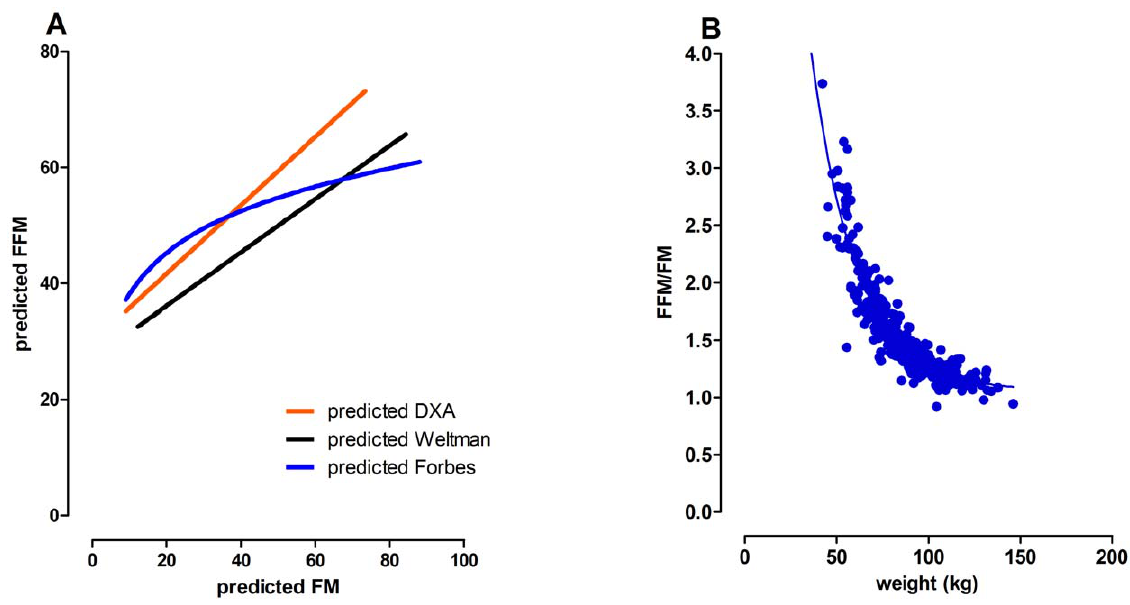
Figure 3. The relationship between the model estimates of FFM and FM is linear. A) Body composition based on modeling DXA-derived data of the full DXA population (IG + CV) using anthropometric variables exhibits a linear relationship between FM and FFM (red line). The anthropometric model of Weltmann [13], derived from hydrostatic weighing in a similar obese female population, is similar (black line). In contrast, data obtained by Forbes [23] for a female population using isotopic dilution methodology is non-linear (blue line). B) The FFM/FM ratio approaches unity for body mass greater than 100 kg.